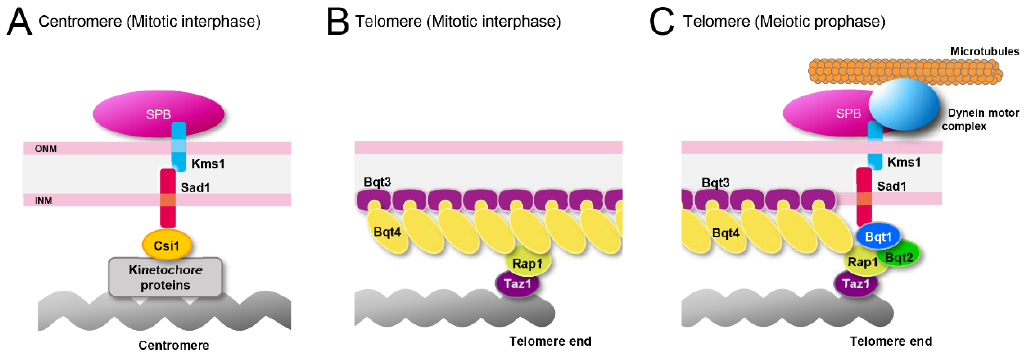
Figure 5. NE proteins attaching heterochromatin regions to the NE. ( A ) Centromeres attached to the SPB in mitotic interphase. ( B ) Telomeres attached to the NE in mitotic interphase. ( C ) Telomeres attached to the SPB in meiotic prophase.